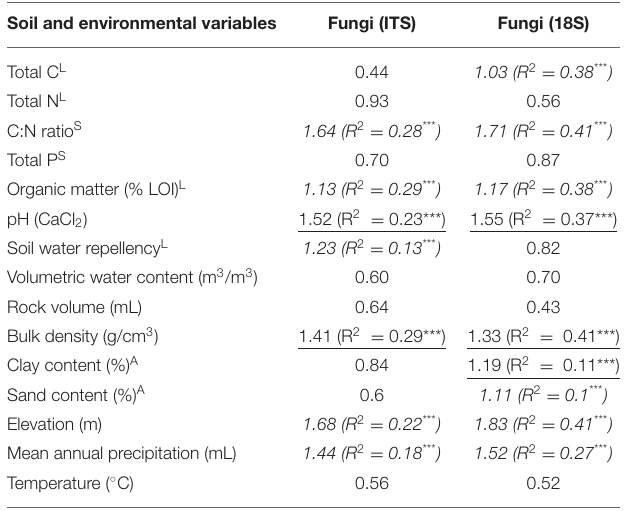
TABLE 2 | Results of partial least squares regressions for fungal richness against environmental variables.